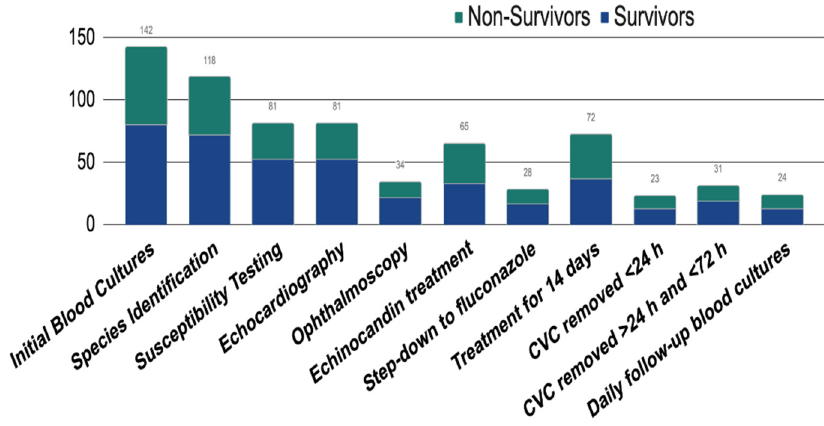
Figure 1. Adherence to quality indicators in 142 cases. Abbreviations: CVC: central venous catheter, h: hours.